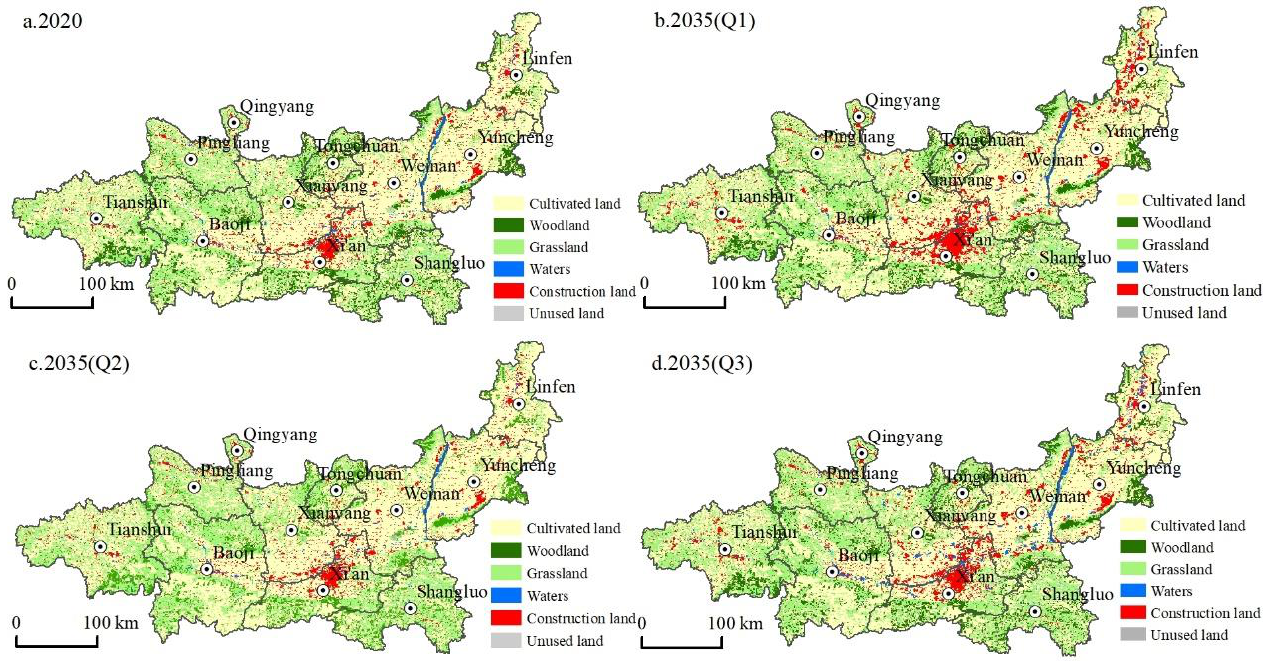
Figure 4. Multi-scenario land use simulation results.